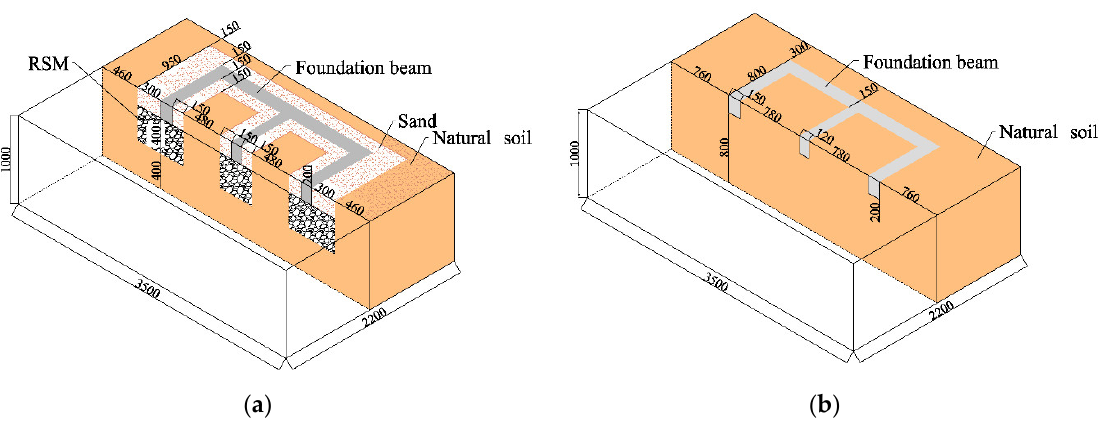
Figure 4. Model of foundation soil (unit: mm): ( a ) the GSI–RSM test; ( b ) the non-isolation test.